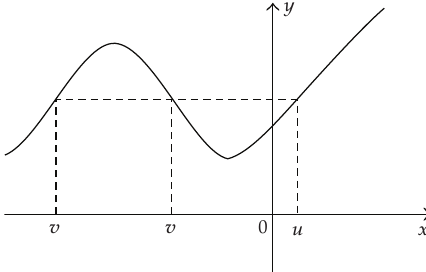
Figure 5: The picture of y (cid:2) f (cid:3) x (cid:4) /g (cid:3) x (cid:4) in (cid:3) 2 (cid:4) (cid:6) .